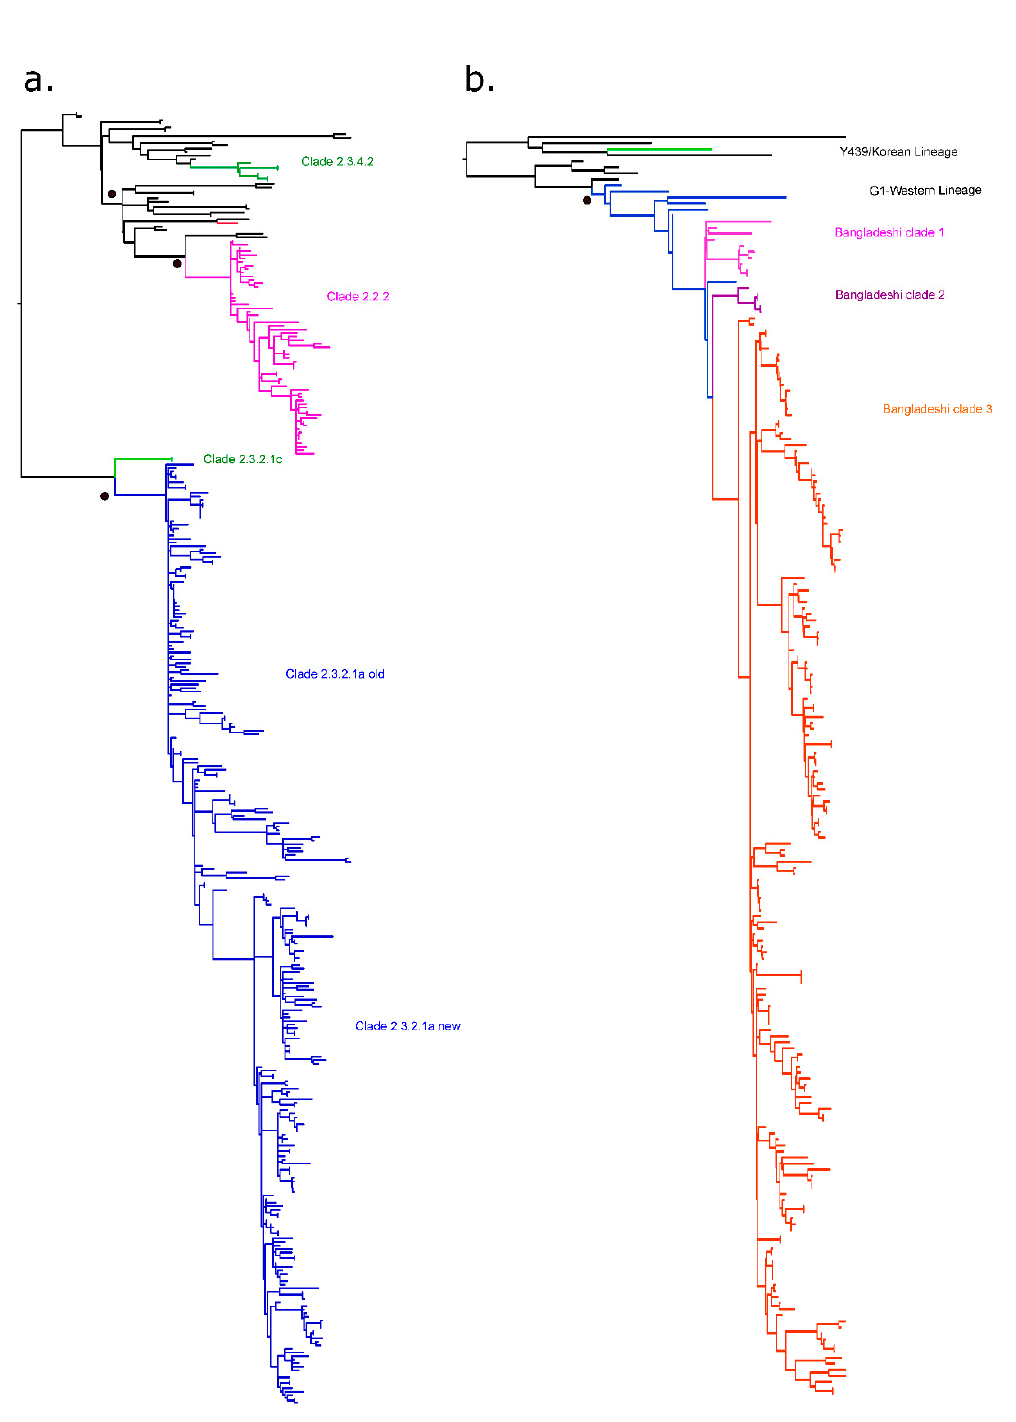
Figure 3. Phylogenetic relationship of HA genes of Bangladeshi high pathogenicity (HP) H5N1 ( a ) and low pathogenicity (LP) H9N2 ( b ) viruses available in public databases (282 H5N1 HA and 201 H9N2 HA ). The trees were generated by use of a maximum likelihood tree method and ultrafast bootstrapping with 1000 replicates with the IQ-Tree software [97,98]. ModelFinder embedded in IQ-Tree [99] was used to select the best fitted substitution model according to the Bayesian information criterion (GTR + F + I + G4). The colored branches represent isolates detected in Bangladesh. Black circles indicate the approximate position in each clade of the vaccine strains used or licensed for use in Bangladesh. Extended versions of these trees are shown in Supplemental Figure